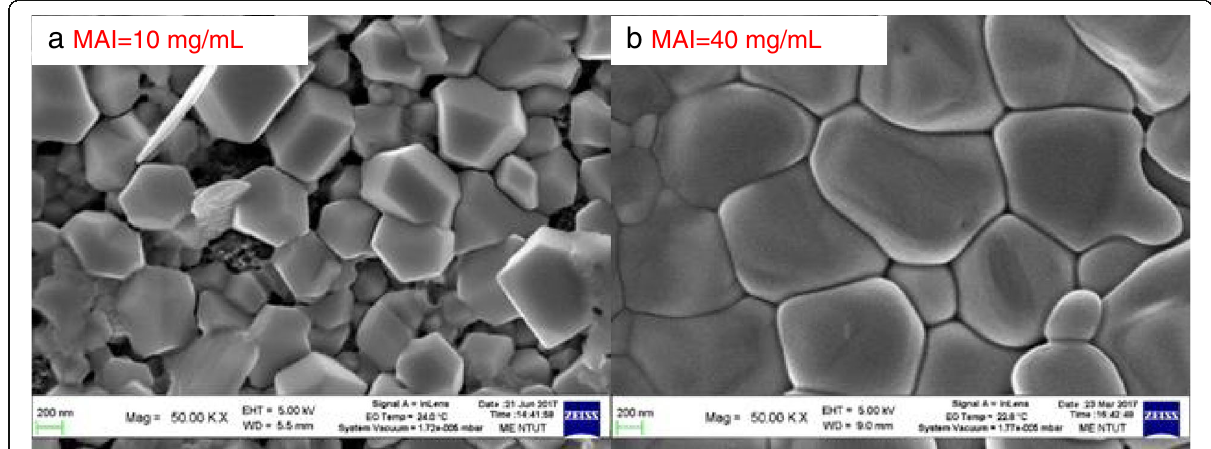
Fig. 6 SEM images of the MAPbI 3 perovskite films with a low- and b high-concentration MAI solution under optimum conditions,